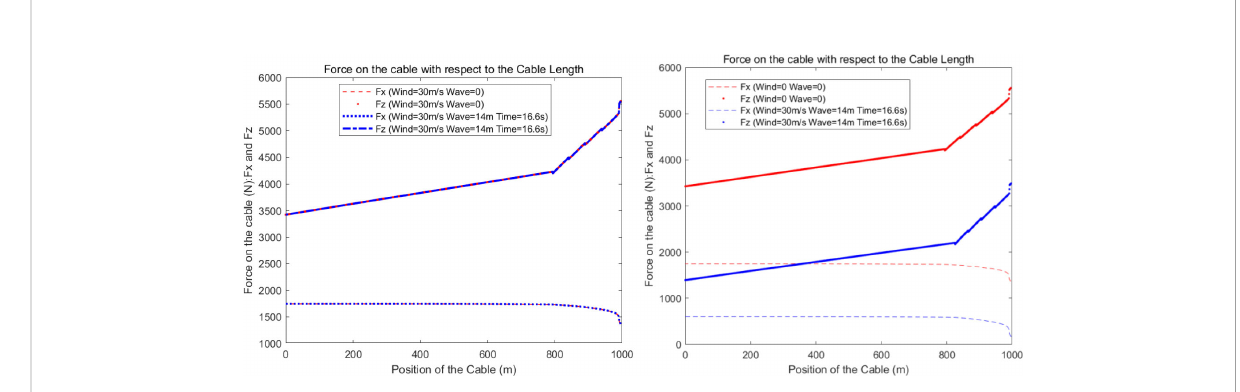
FIGURE 7 Mooring tension along the vertical direction F z and horizontal direction F x for different weather conditions for a Nilspin cable with the snubber up.